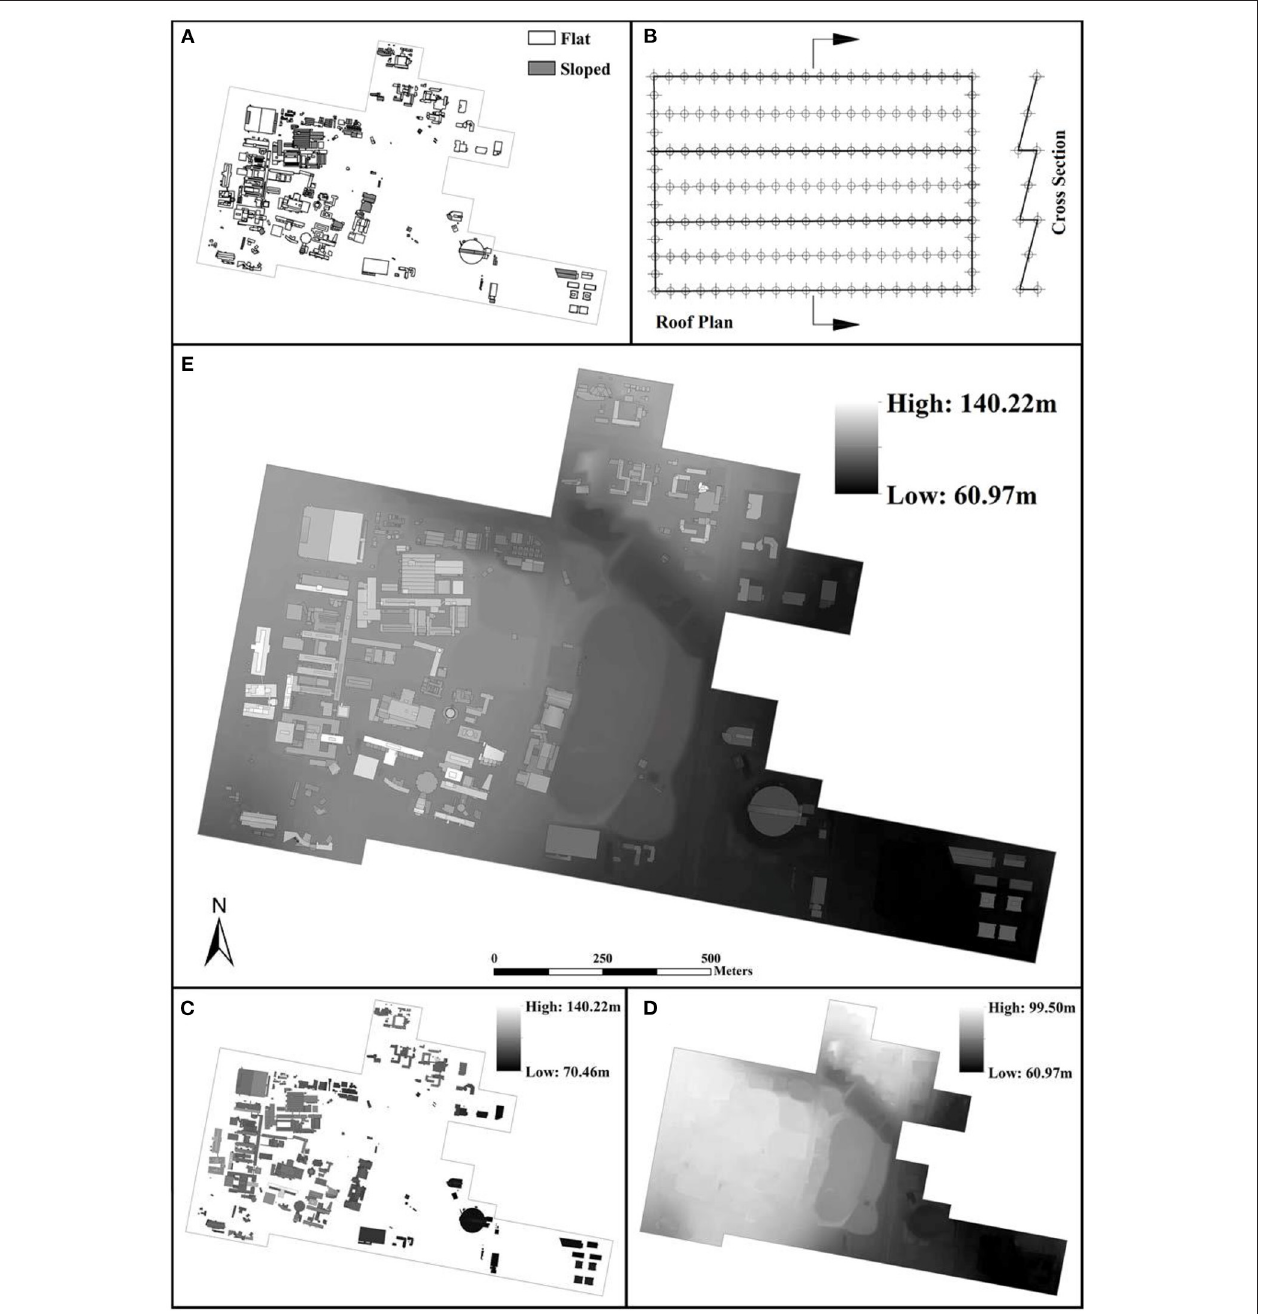
FIGURE 3 | (A) Rooftop polygon classification; (B) sloped rooftop polygon points; (C) raster rooftop polygons; (D) digital elevation model (DEM); (E) digital surface model (DSM) (Radosevic et al.,